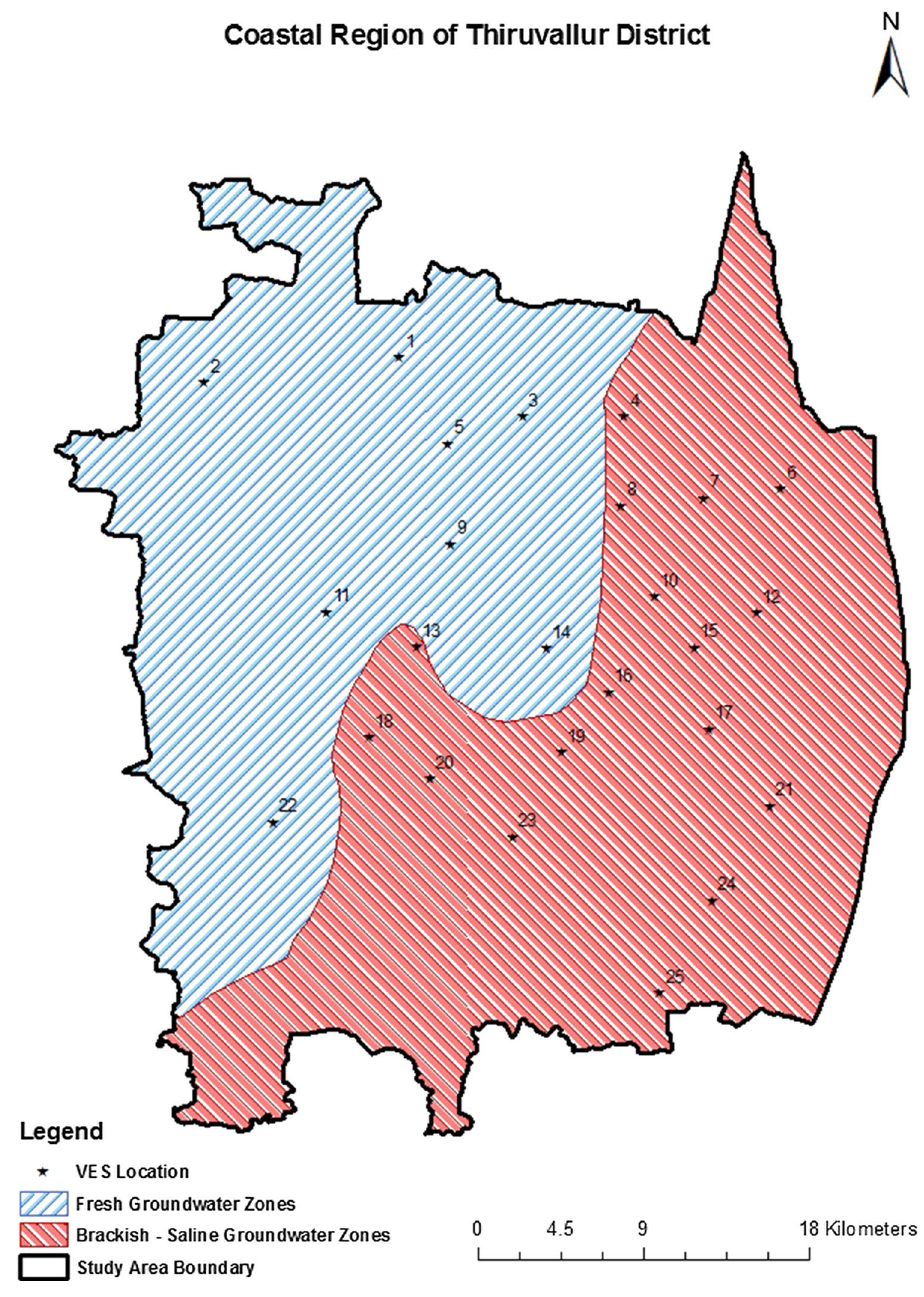
Fig. 15 Final overlay map for fresh-brackish water zone of the